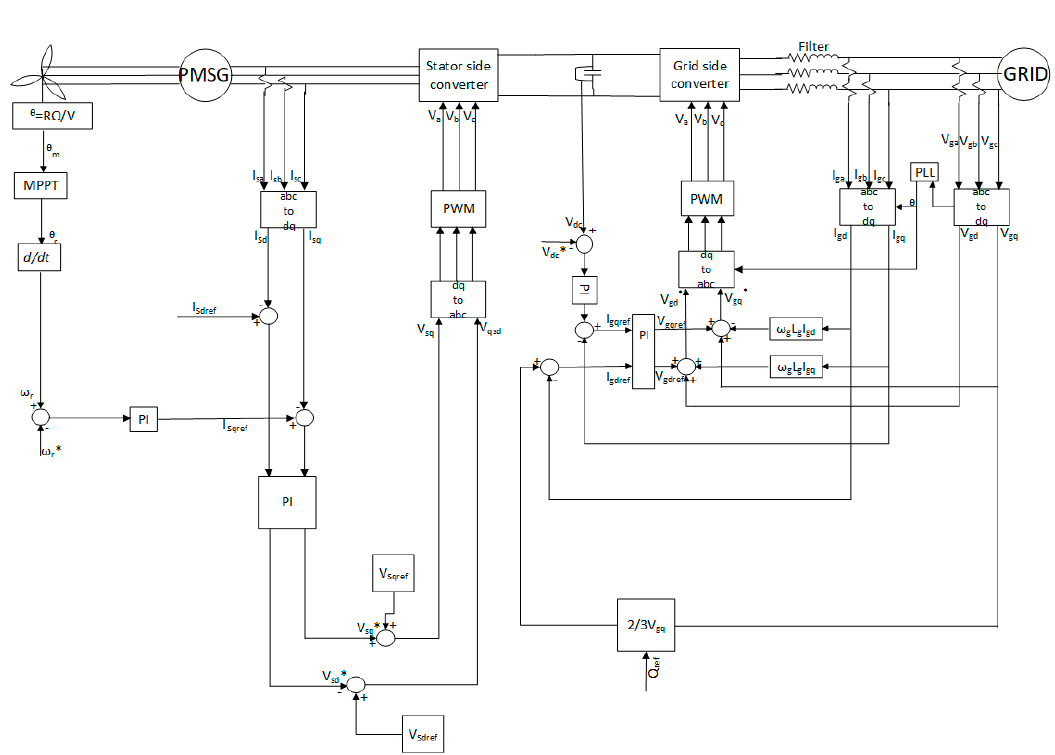
Figure 7. Control of the PMSG, including MPPT, PI controllers, converters, PWM, PLL and filter.